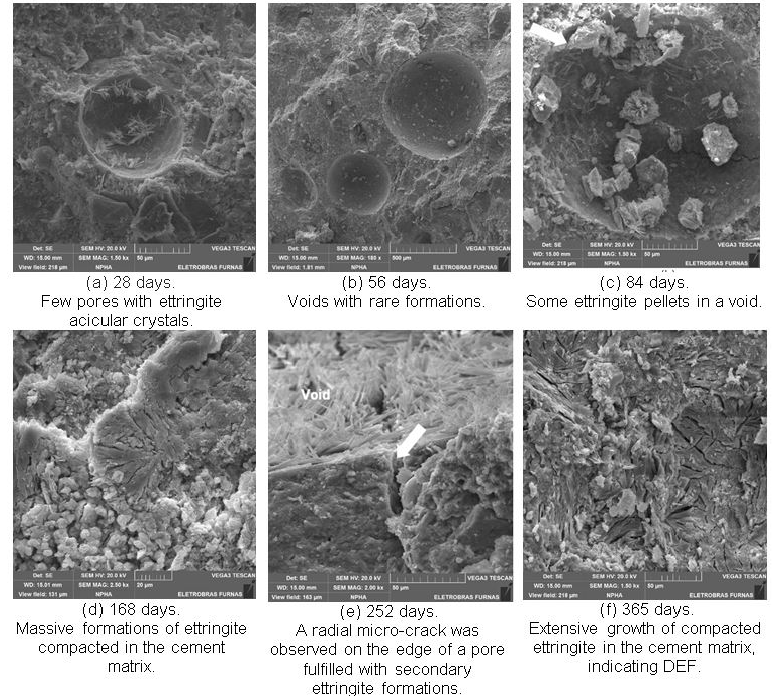
Figure 22. Micrographs of concrete with Type IP